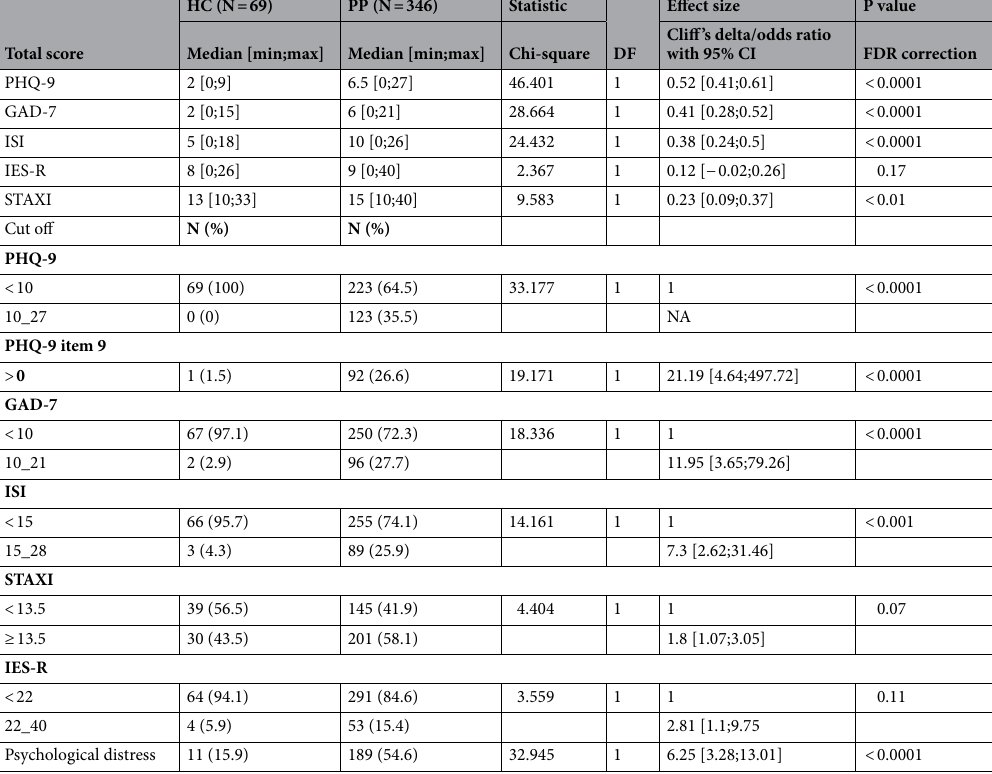
Table 2. Description of psychological outcomes. DF degree of freedom, GAD‑7 7 ‐ item Generalized Anxiety Disorder, HC healthy controls, IES‑R Impact of Events Scale-Revised, ISI Insomnia Severity Inventory, NA not applicable, PHQ‑9 9 ‐ item Patient Health Questionnaire, PP psychiatric patients, STAXI state State-Trait Anger Expression